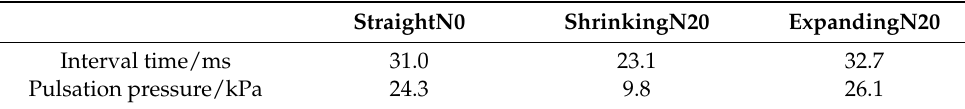
Table 6. Characteristic parameters of the pulsation pressure of the bubble when different nozzles were installed.